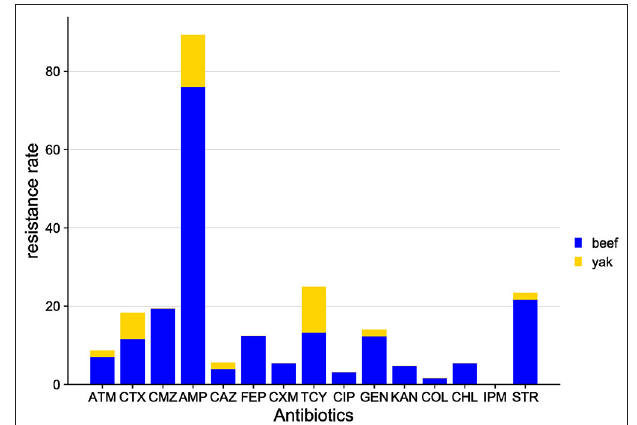
FIGURE 4 | Distribution of antibiotic resistant phenotypes in E. coli from Xinjiang.